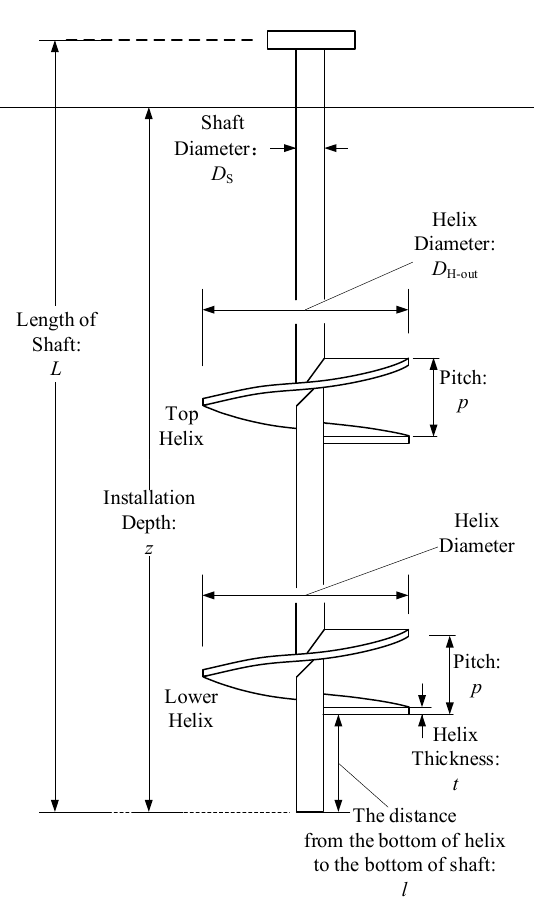
Figure 1. The definitions of typical helical pile.